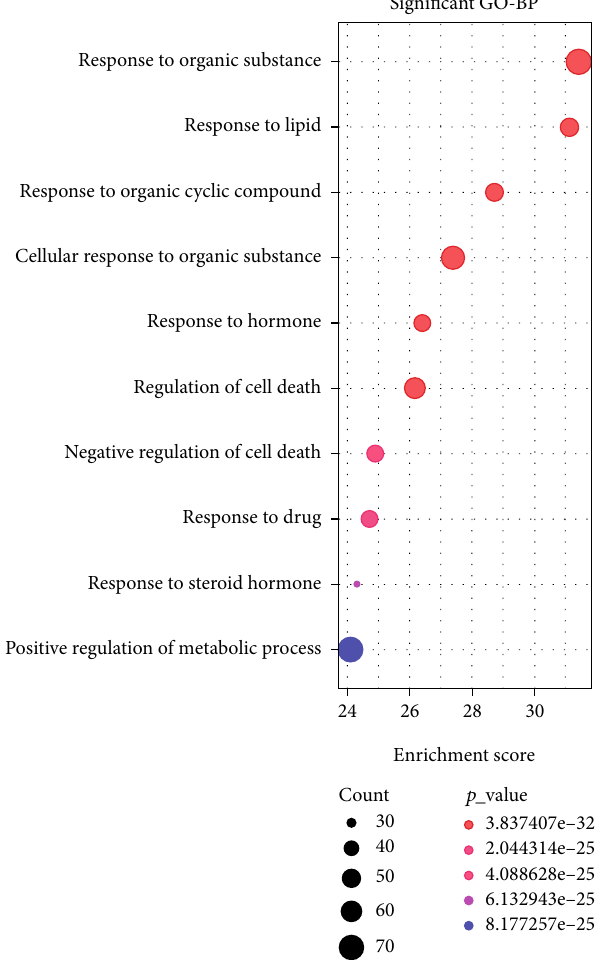
Figure 6: GO enrichment analysis of genes in the network of “ Chinese medicine compound-components-targets ” : bubble